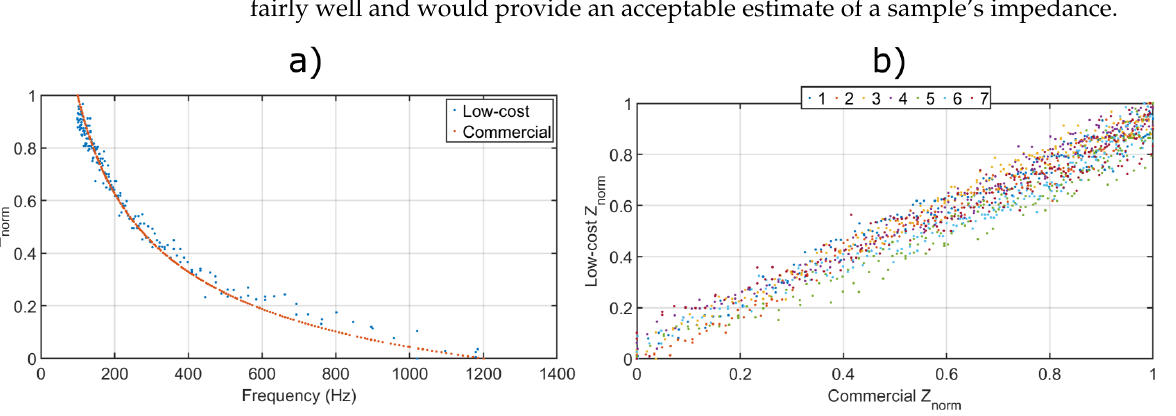
Figure 4. Results from interrogator comparison, ( a ) normalised impedance magnitudes from a single sample EIS, and ( b ) the impedance magnitudes measured at all frequencies for seven individual